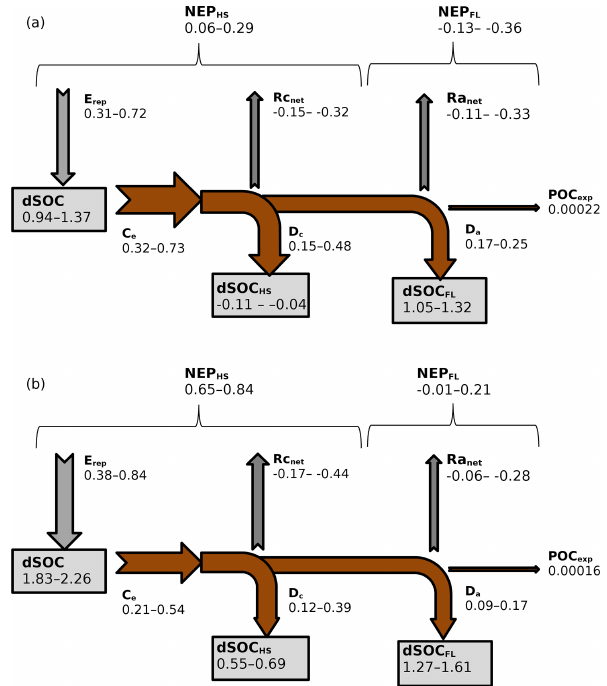
Figure 8. (a) C budget of the non-Alpine part of the Rhine for the period 1851–1861 and (b) for the period 1995–2005. The bud- get shows the net exchange of C (TgCyr − 1 ) between the soil and atmosphere as a result of accelerated soil erosion rates. Gray ar- rows are the erosion-induced yearly-average vertical C fluxes, while the brown arrows are the erosion-induced yearly-average lateral C fluxes. C e is gross C erosion from hillslopes; D c is deposition of C on hillslopes; D a is deposition of C in floodplains; POC exp is net POC export flux; E p is erosion-induced C replacement on hill- slopes (Eq. 21); Ra net is net respiration or burial of deposited C in floodplains (Eq. 23); Rc net is net respiration or burial of deposited C on hillslopes (Eq. 22); NEP HS is net ecosystem productivity of hillslopes; NEP FL is net ecosystem productivity of floodplains. The gray boxes represent yearly-average changes in SOC stocks for the specific time period as a result of land use change, climate change, erosion, and deposition. dSOC is yearly-average change in the to- tal SOC stock; dSOC HS is yearly-average change in the hillslope SOC stock; dSOC FL is yearly-average change in the floodplain SOC